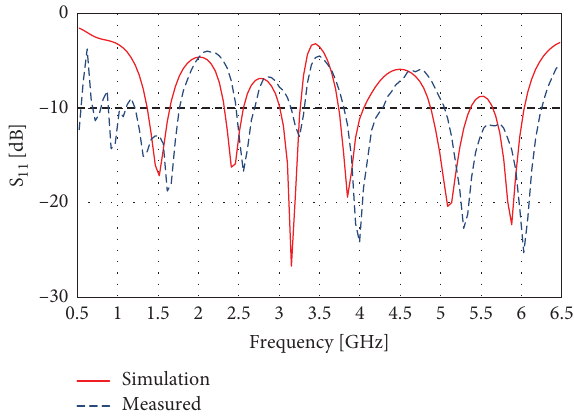
Figure 17: Antenna measured value and simulated value comparison.